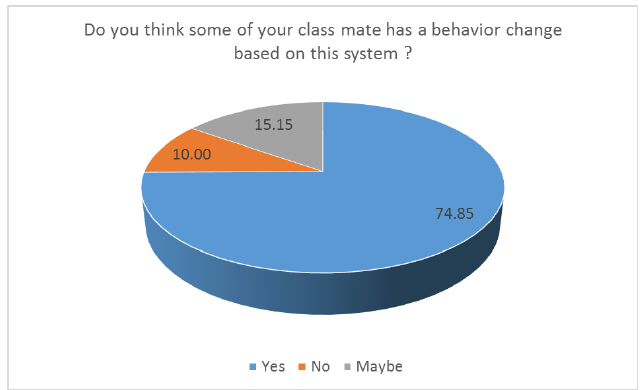
Figure 3. Behavior